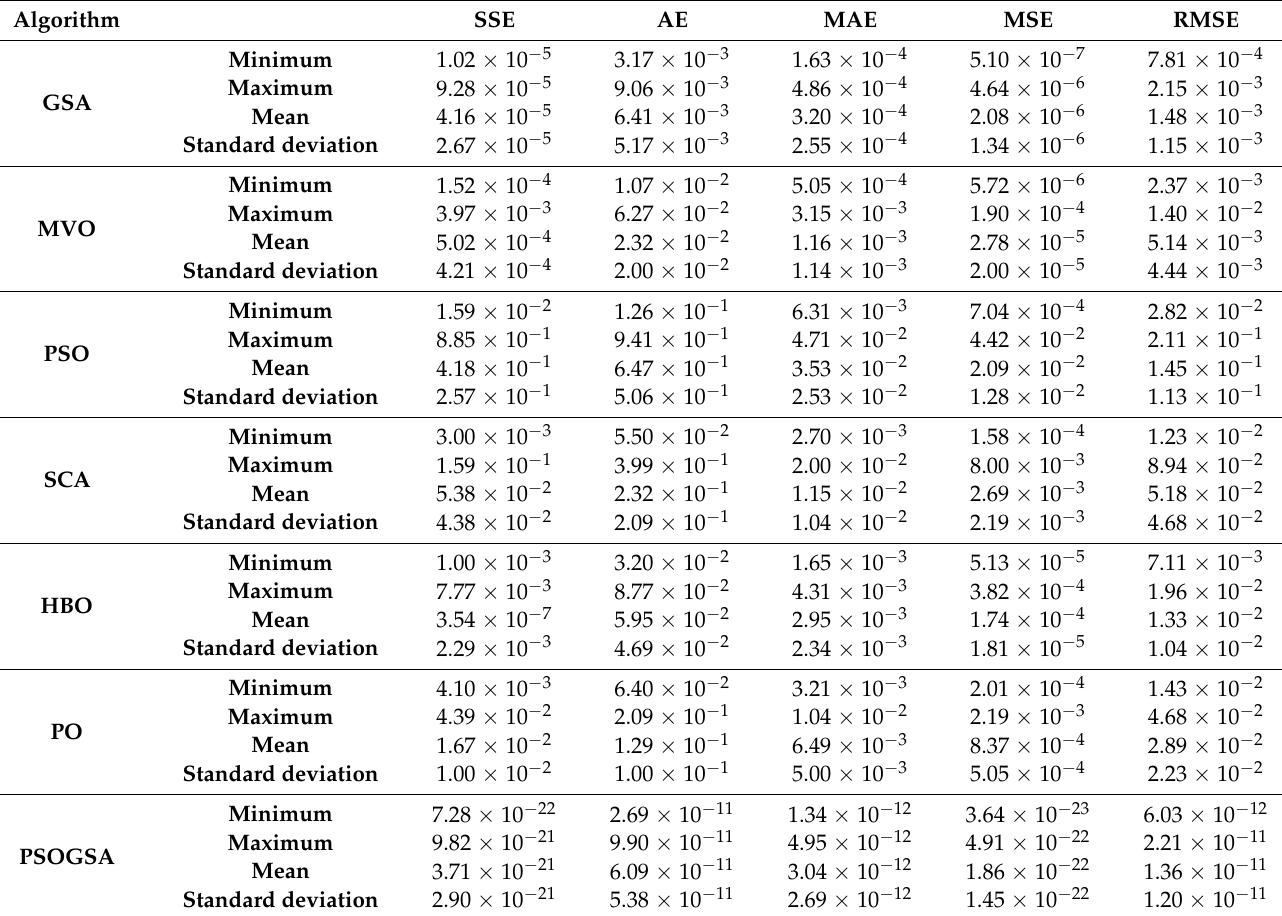
Table 15. The MDDM calculation error, mean and standard deviation for Case 2.